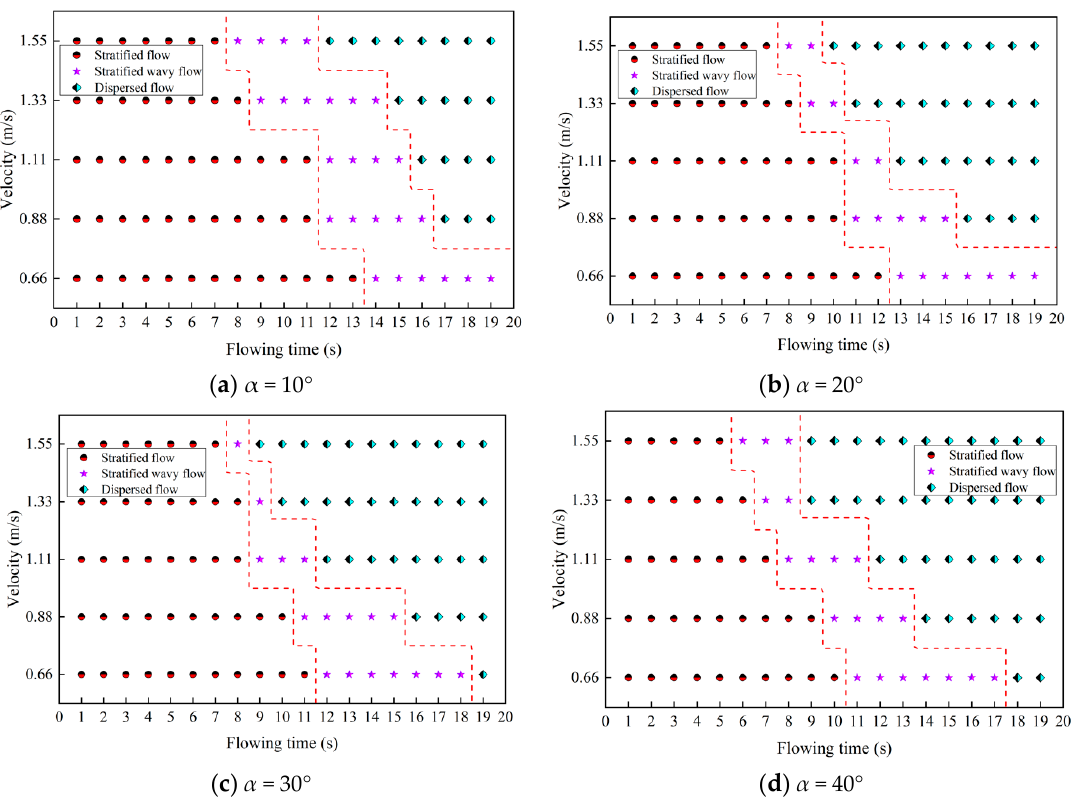
Figure 14. Flow pattern changes under various operating conditions.